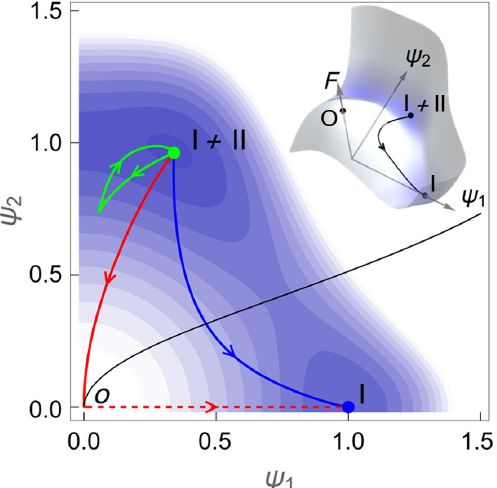
FIG. 6. Contour plot of the free-energy landscape for inter- twined orders. Lower energy appears bluer. The parameters used are ð α 1 ; α 2 Þ ¼ ð 2 . 0 ; 2 . 05 Þ , ð γ 1 ; γ 2 Þ ¼ ð 2 ; 1 Þ ps − 1 , c ¼ 1 , and d 1 ¼ 4 . The lines are different trajectories the system undergoes in the pump-cooling process. Red dashed line means the process is led by exponentially growing fluctuations. Thin black line is the boundary of the basin of attraction of minimum I. Inset: Free- energy landscape plotted in